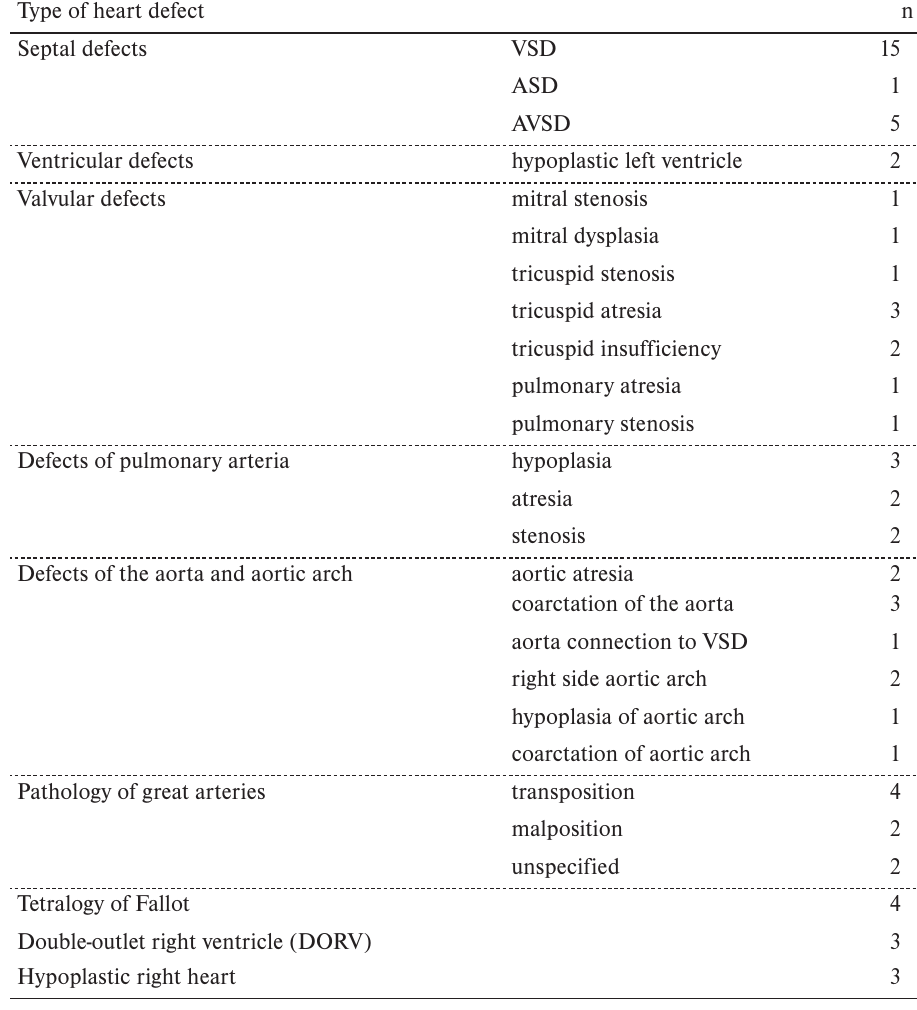
Table 1. Distribution of the types of heart defects in the